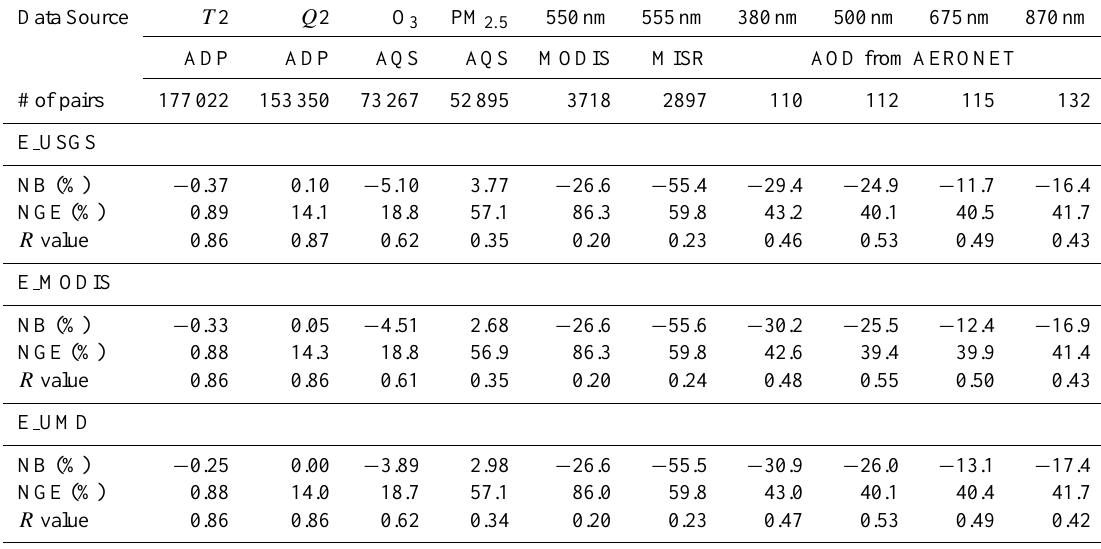
Table 3. Summary of statistics comparing with